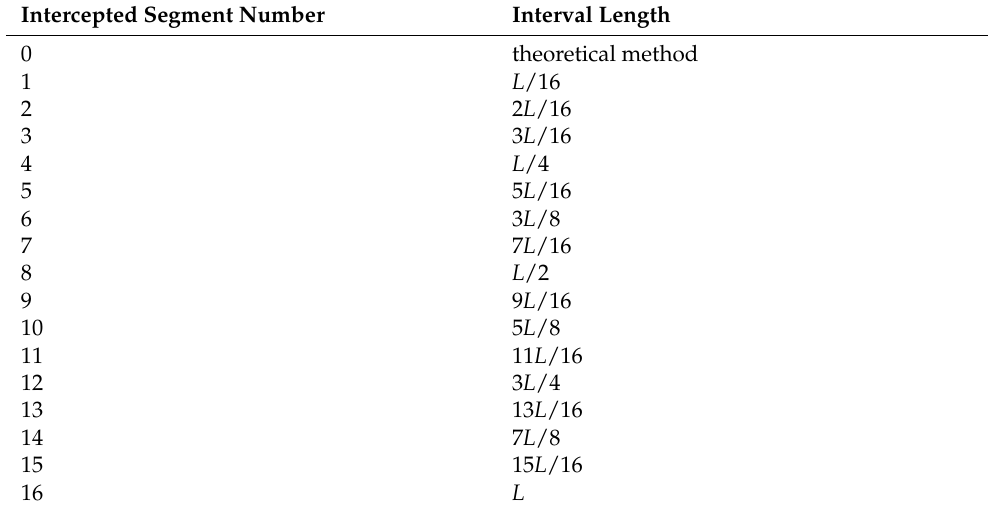
Table 3. Parameters of the segments.